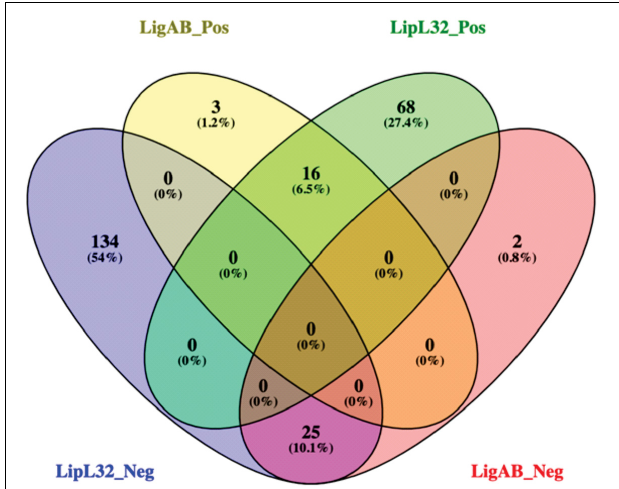
FIGURE 3 | Venn diagram of shared proteins differentially expressed between LigAB and LipL32 mutants compared with empty dCas9 plasmid containing leptospires. Depicted are the number of significant DE proteins (FDR of 0.05) with a positive fold change between LigAB and dCas9-alone (yellow, indicating proteins that were more abundant in the LigAB mutant), negative fold change between LigAB and dCas9-alone (red, indicating proteins that were less abundant in the LigAB mutant). Also shown are the number of significantly DE proteins (FDR of 0.05) with a positive fold change between LipL32 and dCas9-alone (green, indicating proteins that were more abundant in the LipL32 mutant), negative fold change between LipL32 and dCas9-alone (blue, indicating proteins that were less abundant in the LipL32